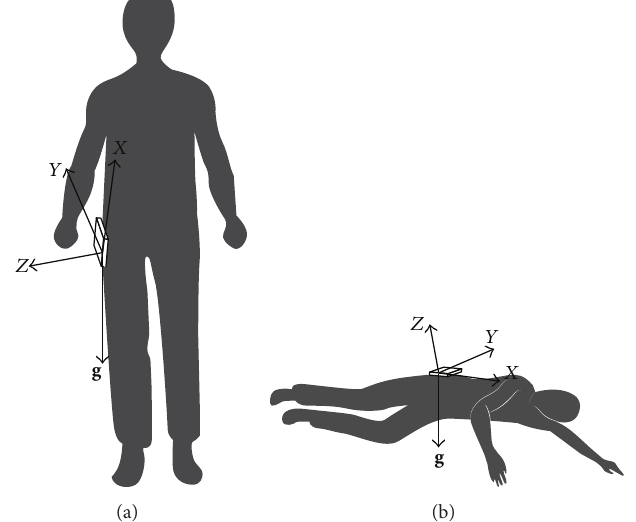
Figure 2: Coordinate and gravity before and after falling. (a) Before falling. (b) After falling.